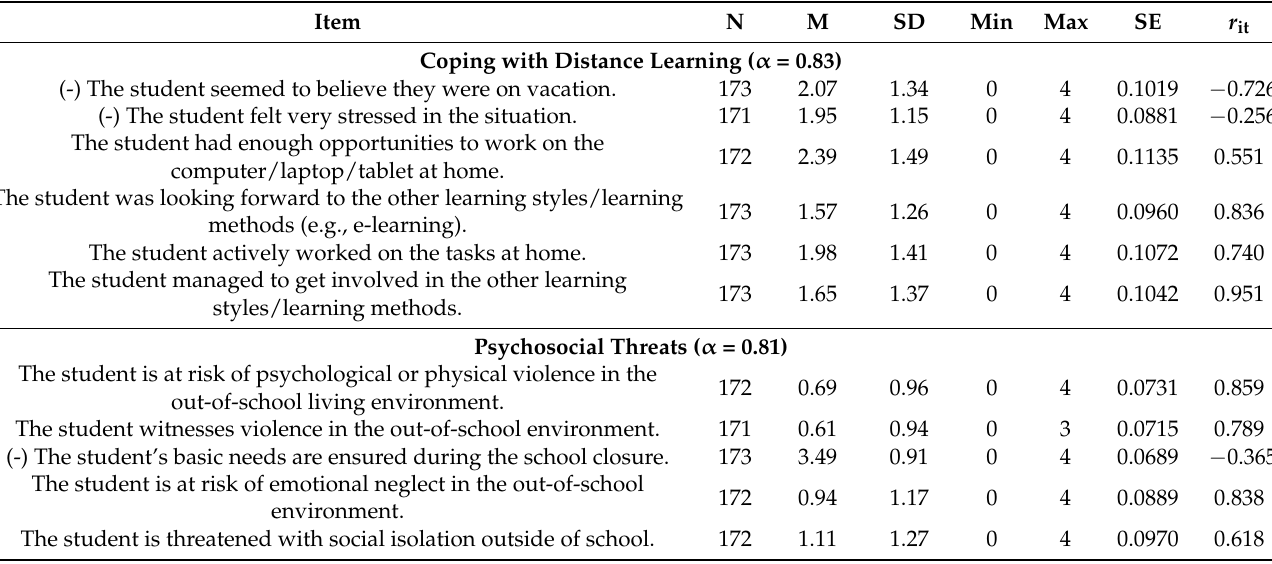
Table A3. Item and scale properties of the measurements for students’ coping with distance learning and psychosocial threats during